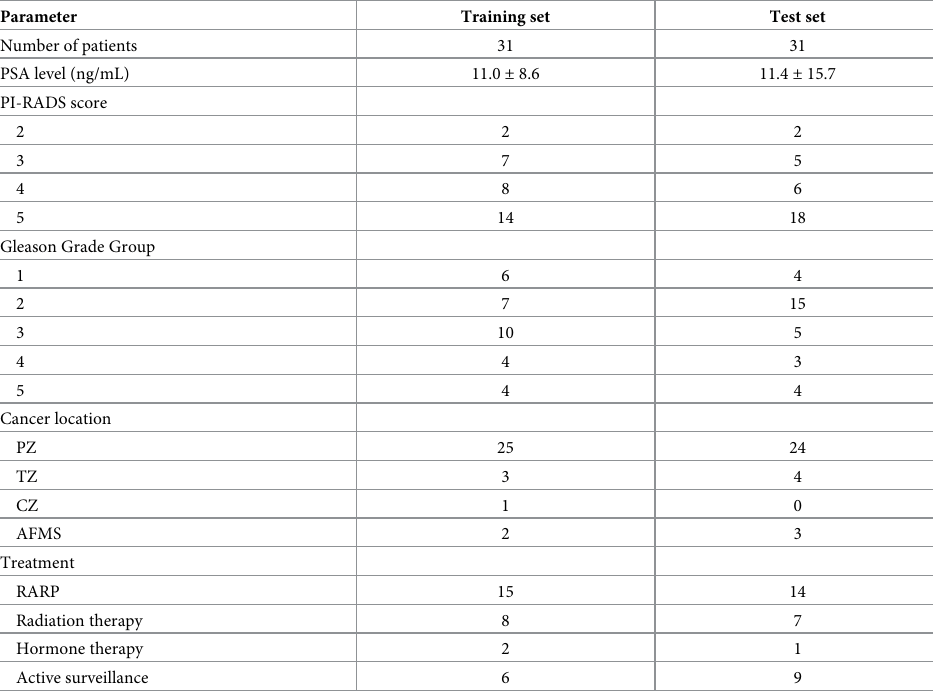
Table 1. Summary of patient characteristics for the 62 included patients with biopsy-confirmed cancer. Training set Test